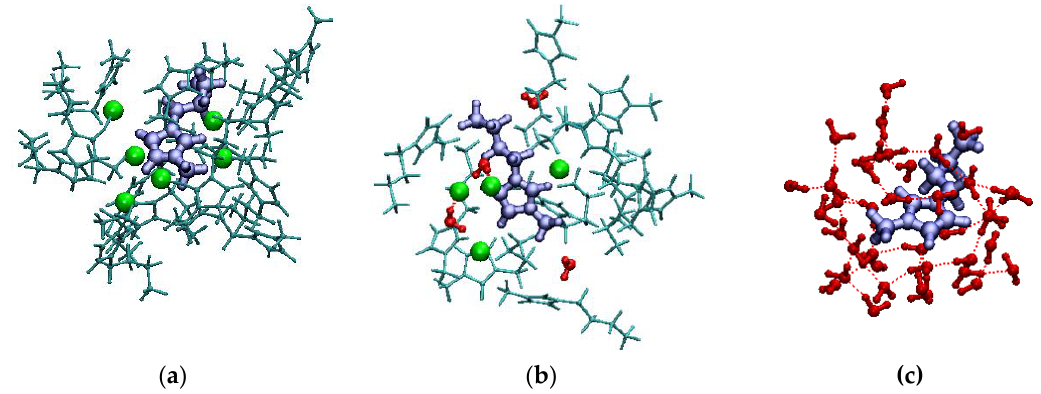
Figure 4. Representative clusters of ( a ) the pure IL system; ( b ) the [C 4 C 1 im]Cl/water mixture with x IL = 0.50; ( c ) the [C 4 C 1 im]Cl/water mixture with x IL = 0.01. In blue, the thick ball and stick are the central imidazolium cations; in green, the chloride anions; in red, the water molecules; in cyan, the thin ball and stick are the other imidazolium cations.